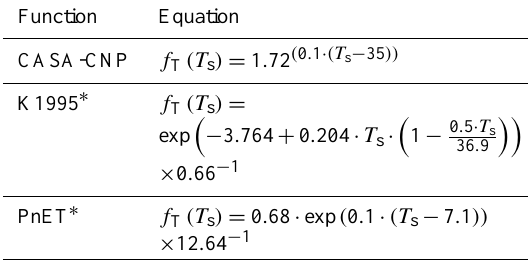
Table 3. Initial total soil carbon at equilibrium for each combination of f W (rows) and f T (columns) in C-only/CN/CNP modes. Values are given in PgC and rounded to the nearest